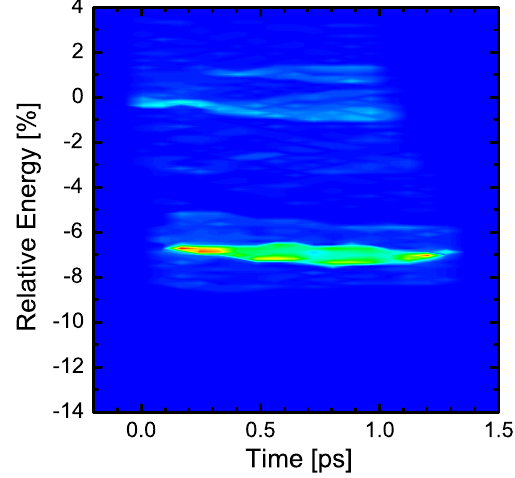
FIG. 11. The longitudinal phase space distribution of the electron bunch obtained by the numerical simulation after the undulator at the end of the macropulse.